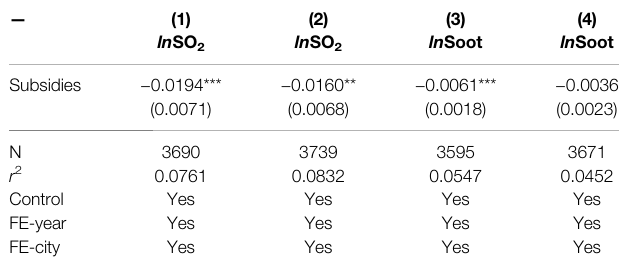
TABLE 9 | Heterogeneity of high discretion slack